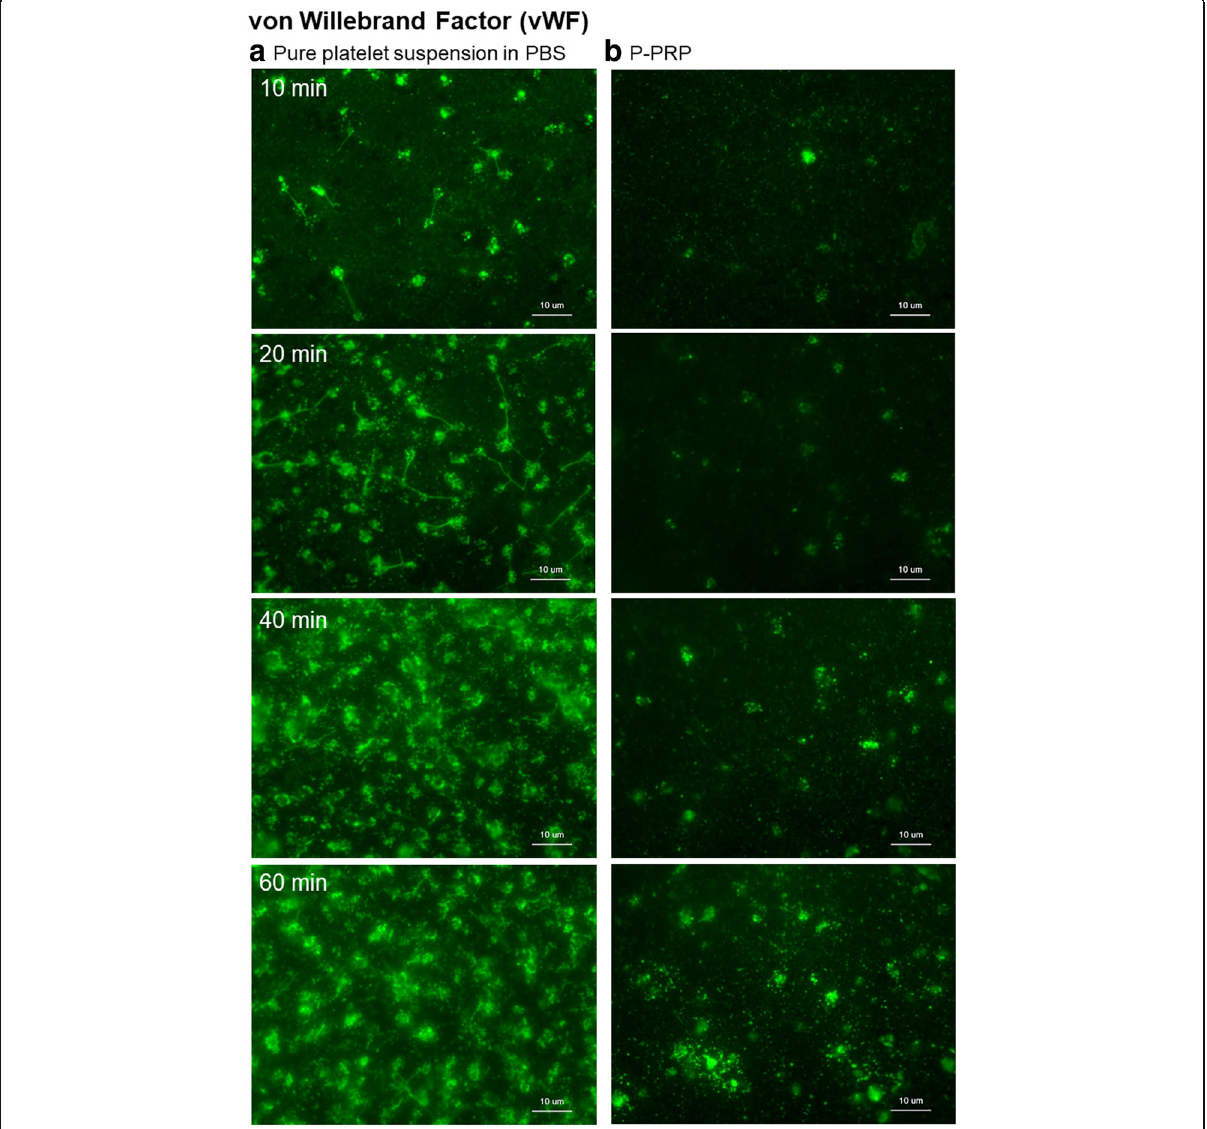
Fig. 5 Distribution of vWF (green dye) on the surface of cp -Ti plates. a Platelets suspended in PBS and b P-PRP. vWF von Willebrand factor, cp - Ti commercially pure titanium, PBS phosphate-buffered saline, P - PRP pure platelet-rich